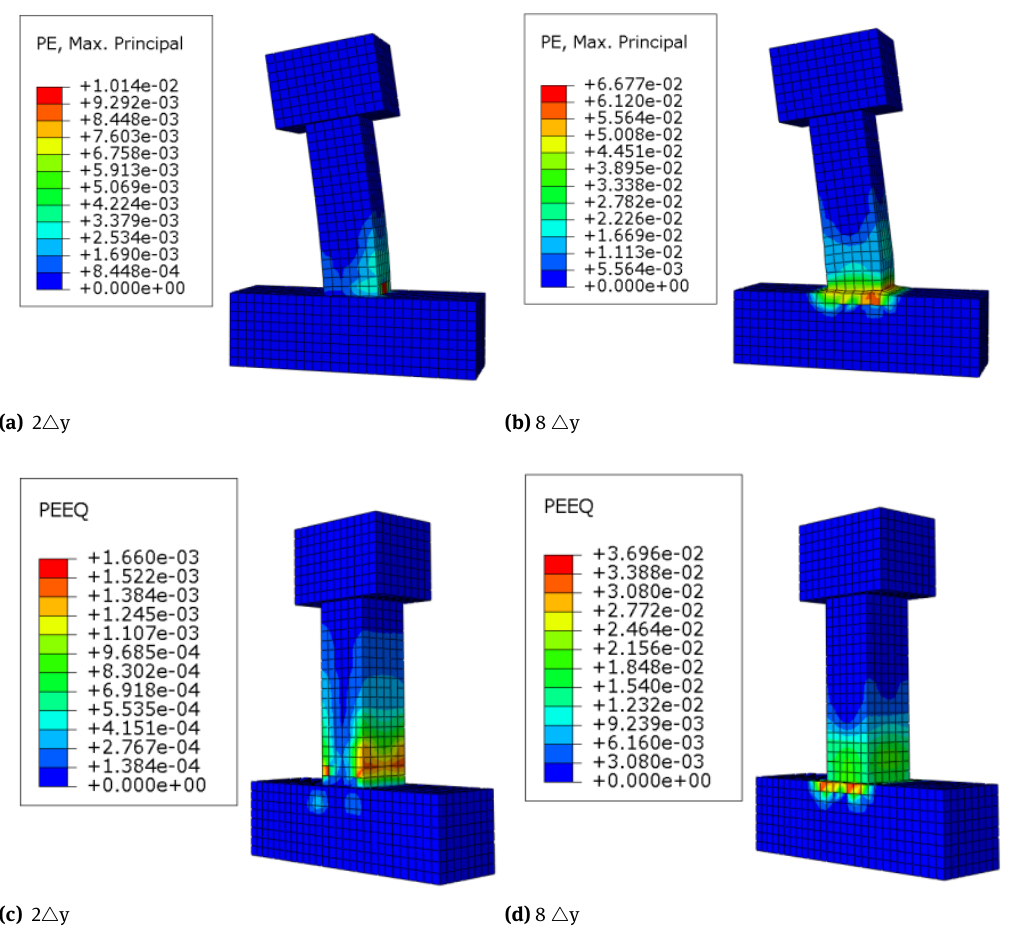
Figure 16: Nephograms of Equivalent Plastic Strain and Maximum Principal Plastic Strain of